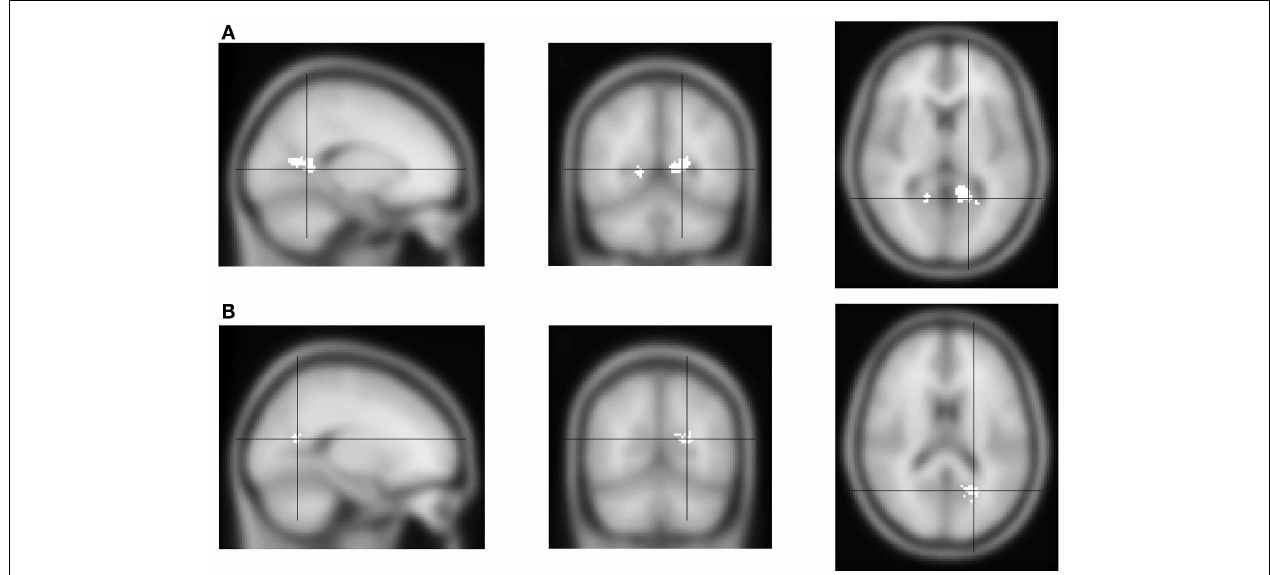
precuneus and posterior cingulate. (B) Interaction of the block contrast with AUDIT-scores: white voxels show the region where contrast values were significantly lower for individuals with higher AUDIT-scores. Activation was again found in medial parietal cortex, but somewhat more